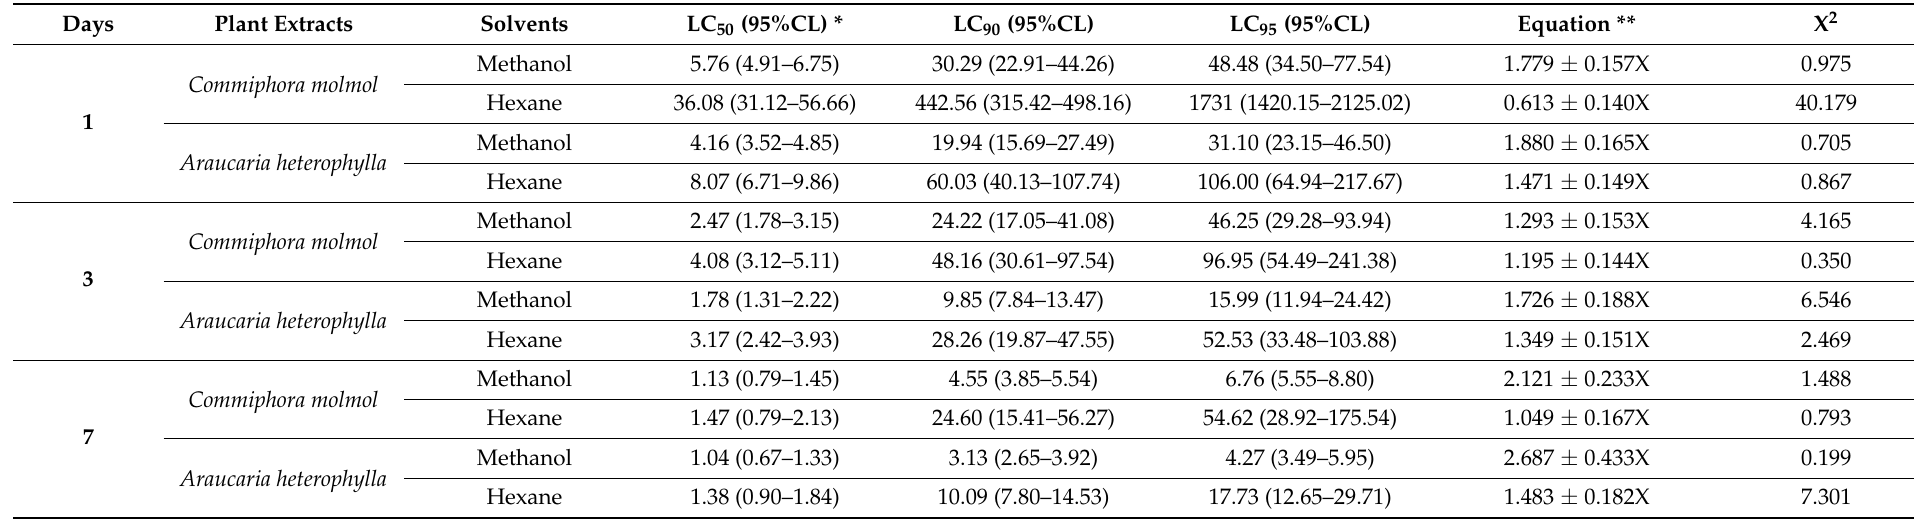
Table 2. Lethal concentration values of plant extracts of Commiphora molmol and Araucaria heterophylla against Hyalomma dromedarii